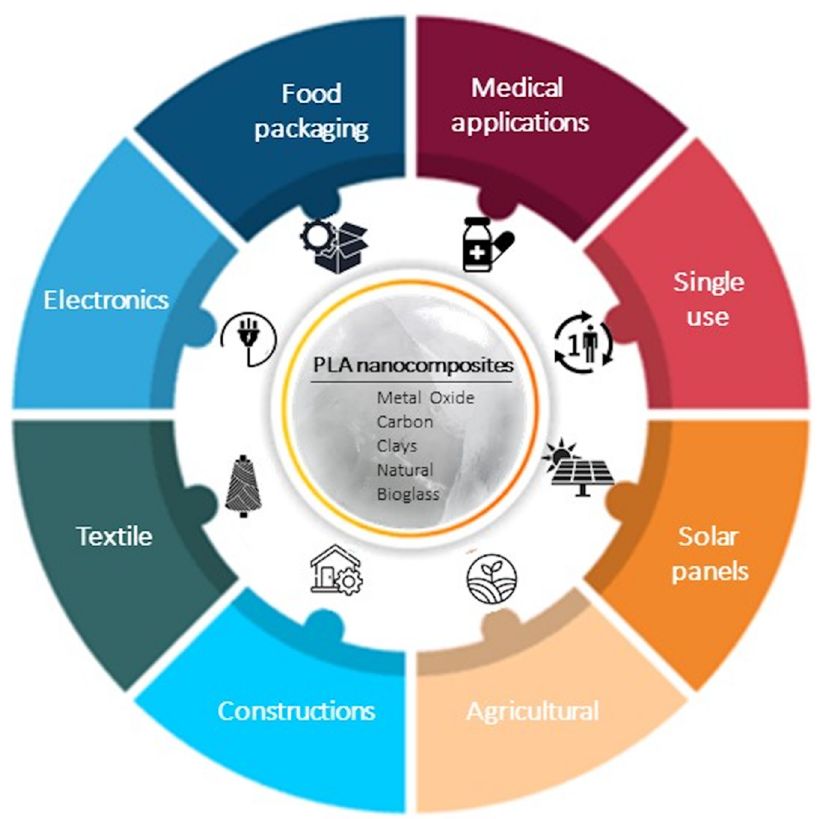
Figure 12. Schematic overview of the numerous applications involving PLA nanocomposites.